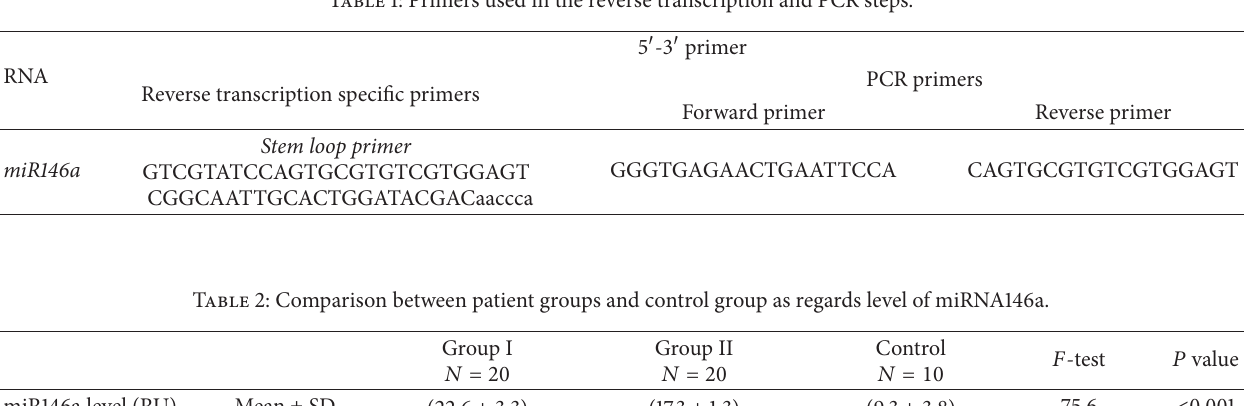
Table 1: Primers used in the reverse transcription and PCR steps.